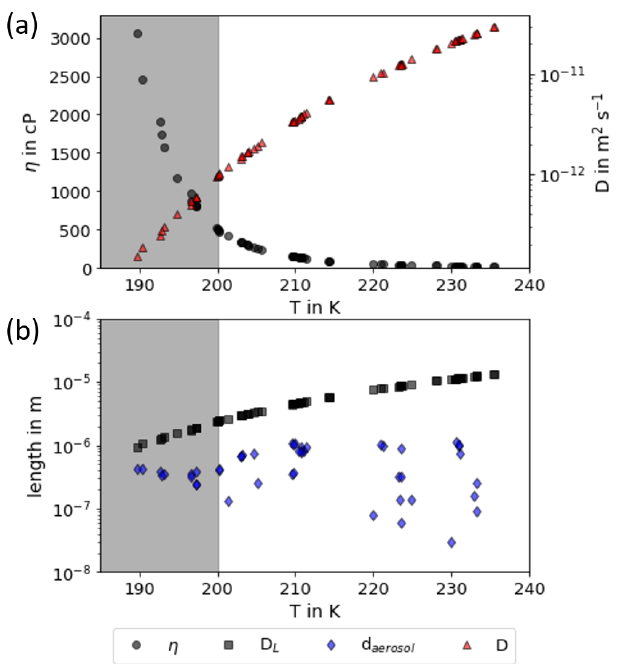
Figure D2. Viscosity and diffusion coefficients for the start conditions of the AIDA experiments. (a) Viscosity (black dots) and diffusion coefficients (red triangles) calculated using the parameterization of Williams and Long (1995) and the Stokes–Einstein equation. (b) Com- parison of the mean particle diameter of the sulfuric acid particle population (blue diamonds) to the diffusion length of water molecules (black squares) on a timescale of 6s. Note that the shown data points represent the starting conditions of the AIDA experiments. As the pa- rameterization of Williams and Long (1995) is only valid for T > 200K, the data points of experiments at lower temperatures are displayed in a grey shaded